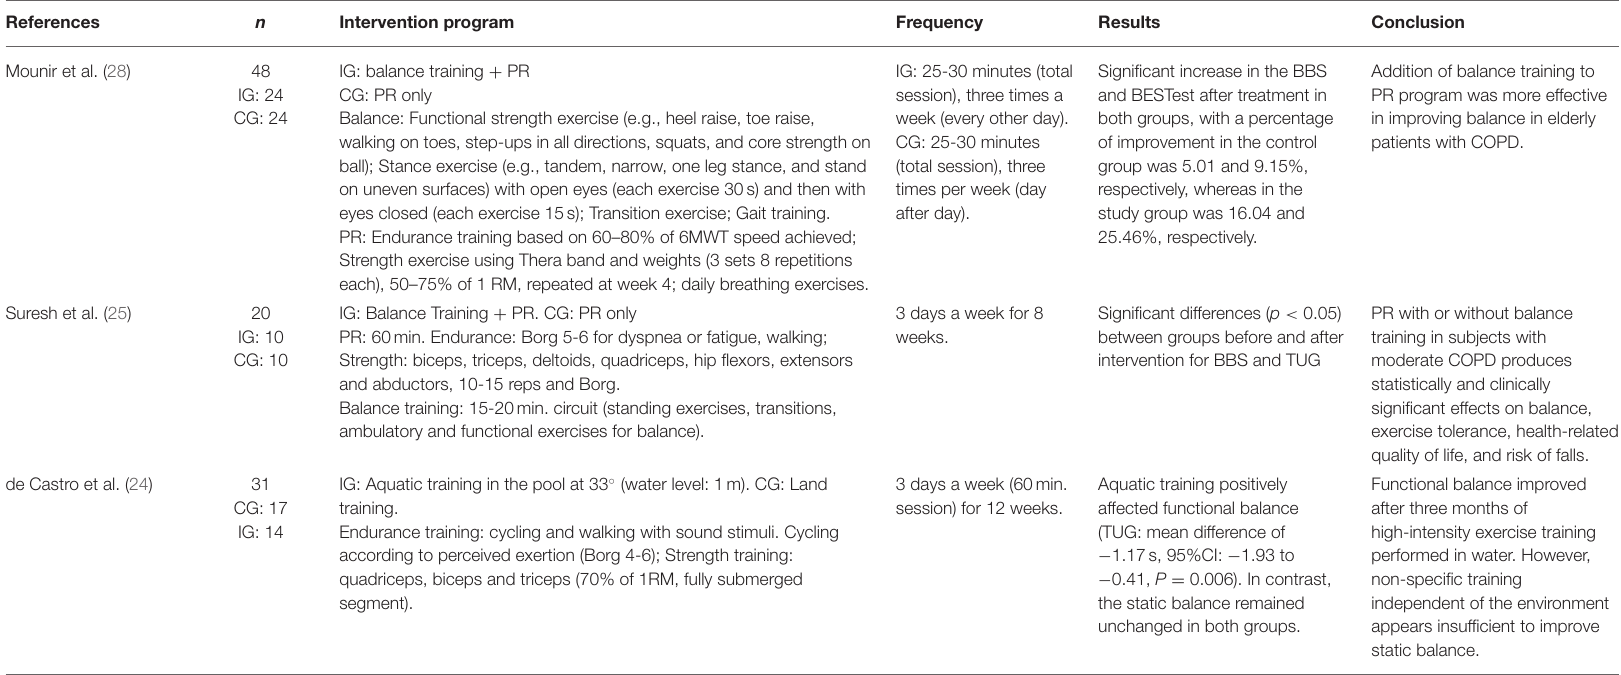
3 days a week for 8 weeks. intervention for BBS and TUG 3 days a week (60min. Aquatic training positively session) for 12 weeks. affected functional balance (TUG: mean difference of − 1.17s, 95%CI: − 1.93 to − 0.41, P = 0.006). In contrast, the static balance remained unchanged in both